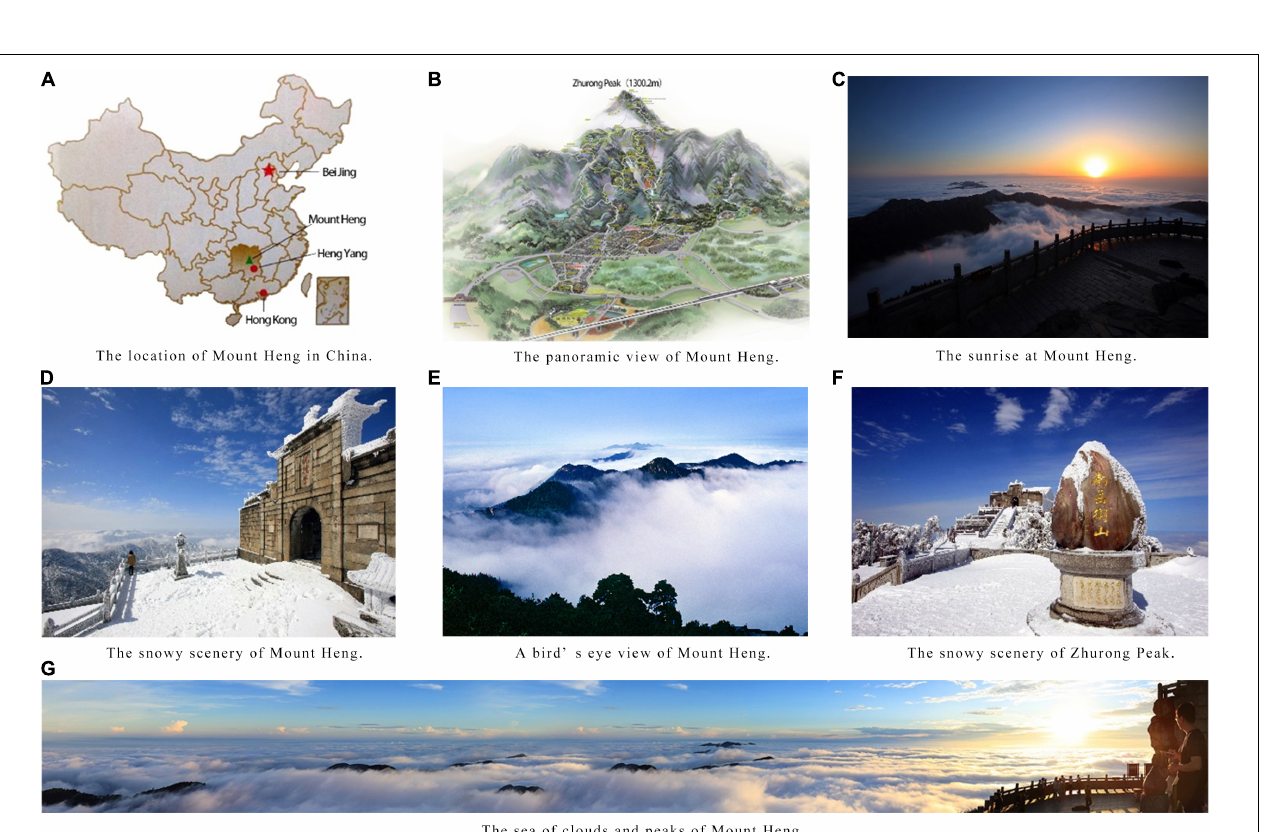
FIGURE 3 | The location (A) and natural scenery (B–G) of Mount Heng. Source: Tourism administration of Nanyue